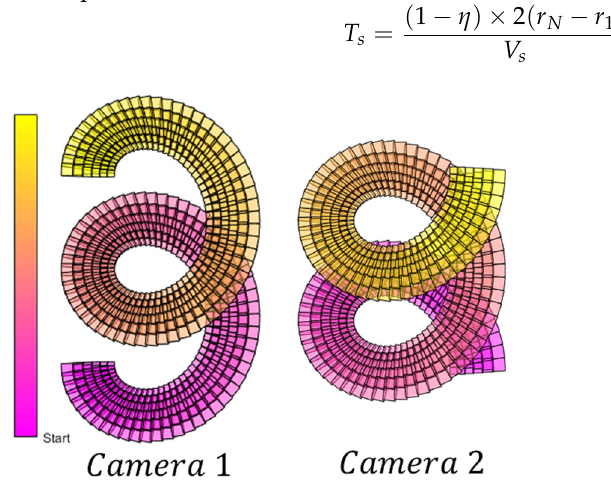
Figure 13. Dual-camera OCPSI mode overlay schematic: separate.